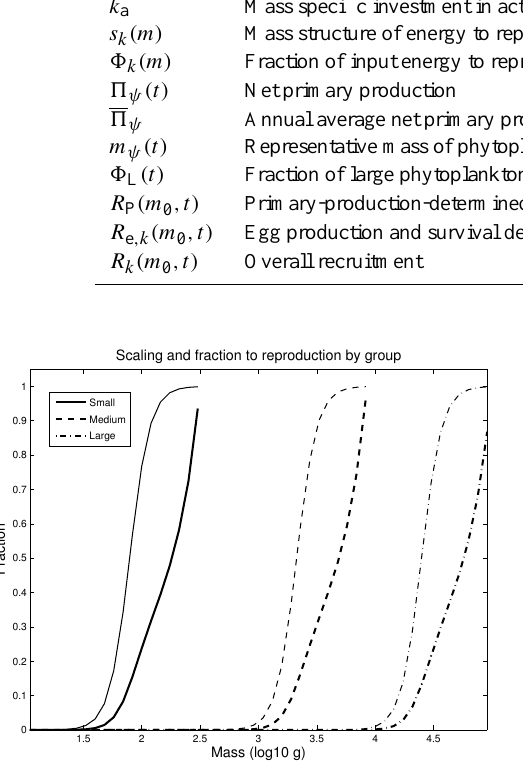
Figure 2. Mass dependence of reproduction by group. The mass scaling function s k (m) (thin lines, Eq. 23) determines the mass de- pendence of the allocation of energy to reproduction. (cid:56) k (m) (thick lines, Eq. 21) is the fraction of energy allocated to